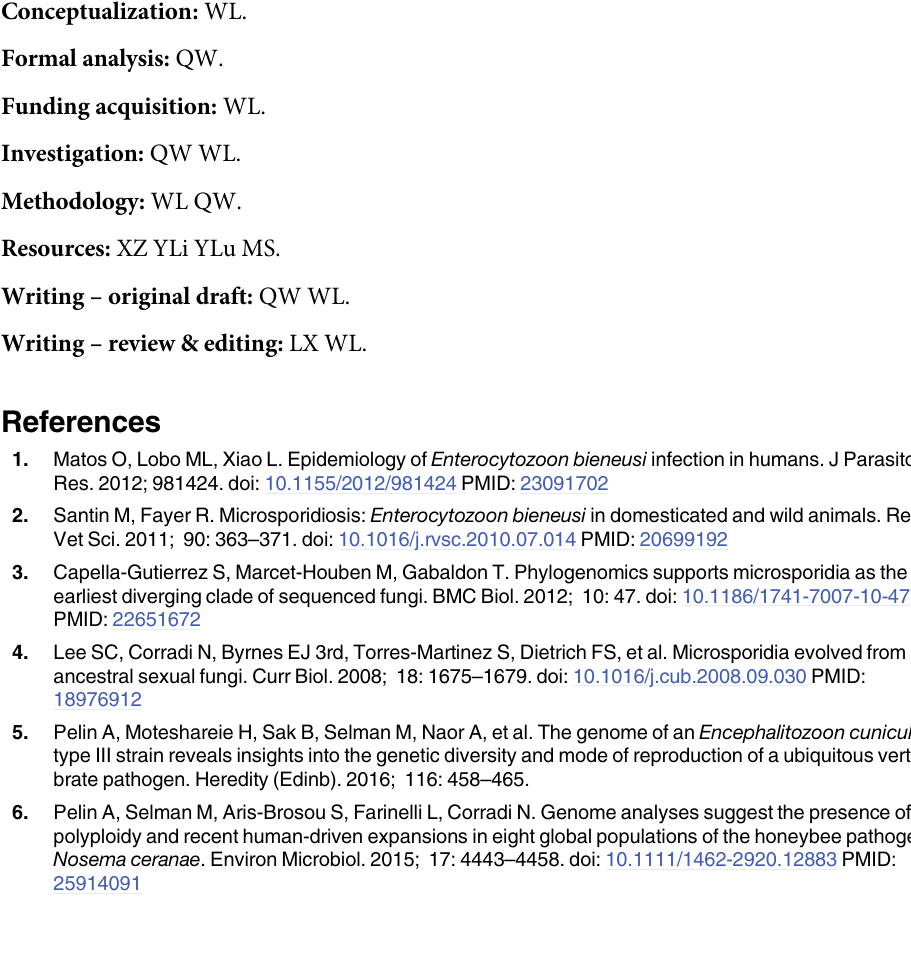
S2 Table. Intergenic linkage disequilibrium. Pairwise P values for intergenic linkage disequi- librium among genetic loci based on allelic profile data from pig Enterocytozoon bieneusi popu- lations. S3 Table. Geographical distribution of specimens in genetic subdivisions. Proportion of the specimens from each city that belong to each of the three pig-derived Enterocytozoon bieneusi subpopulations. S4 Table. Distribution of ITS genotypes by host and location. Host range and geographical distribution of ITS genotypes of Enterocytozoon bieneusi referred in this